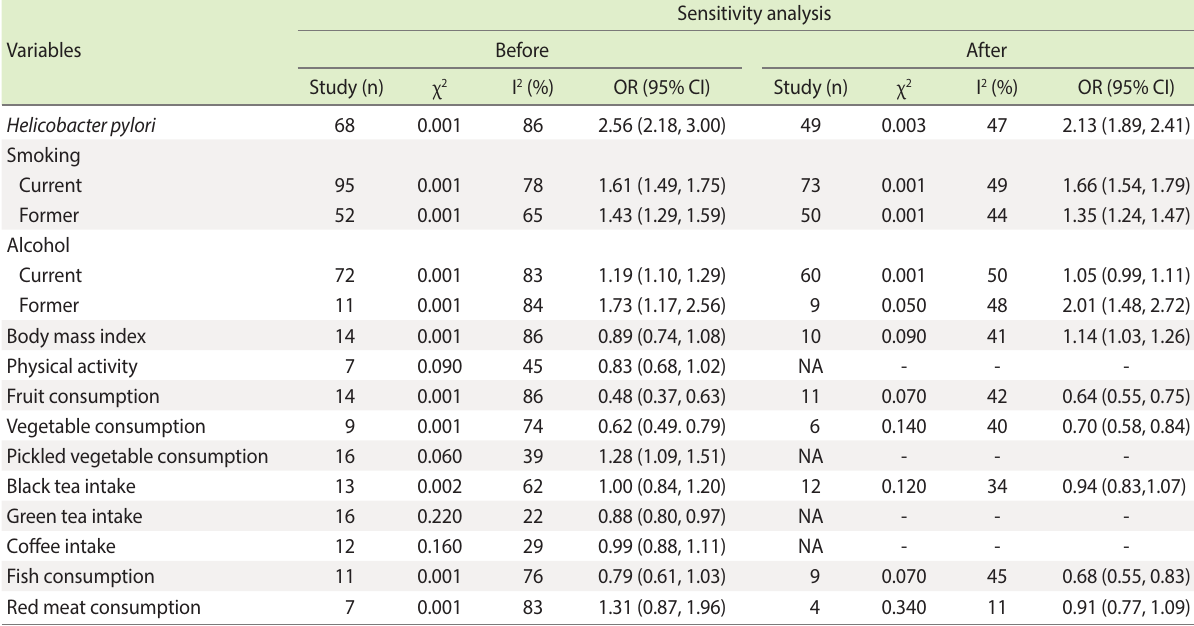
Figure 1. Flow of information through the various phases of the sys- tematic Table 1. Results of the sensitivity analysis